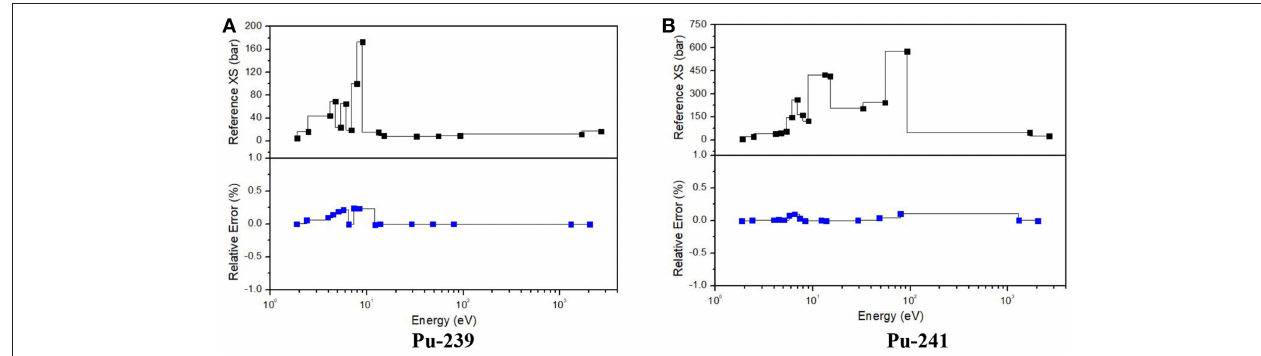
FIGURE 7 | Errors of Pu isotopes absorption cross section of MOX pin. (A) Pu-239, (B) Pu-241.